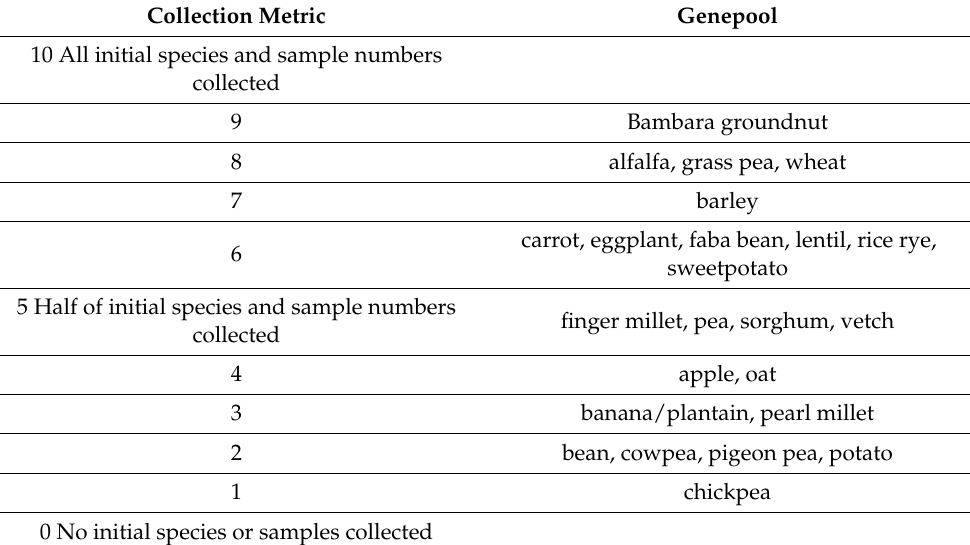
Figure 4. Success of collecting target species and sample numbers per genepool. The collection metric was calculated from these scores. Table 1. Genepools categorized by collection metric score. Collection